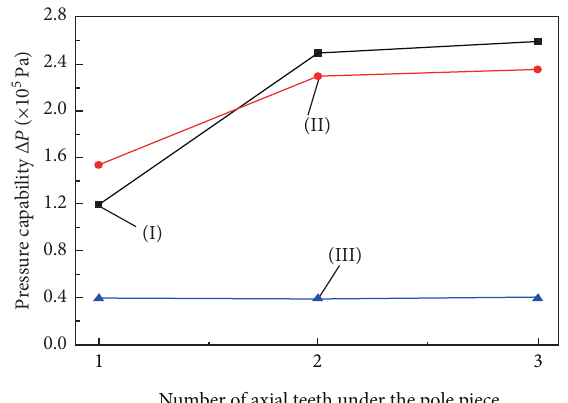
Figure 13: Influence of axial teeth number on pressure resistance ability of magnetic fluid seal. (I) Experimental value of divergent magnetic fluid seal. (II) Theoretical value of divergent magnetic fluid seal. (III) Experimental value of ordinary magnetic fluid